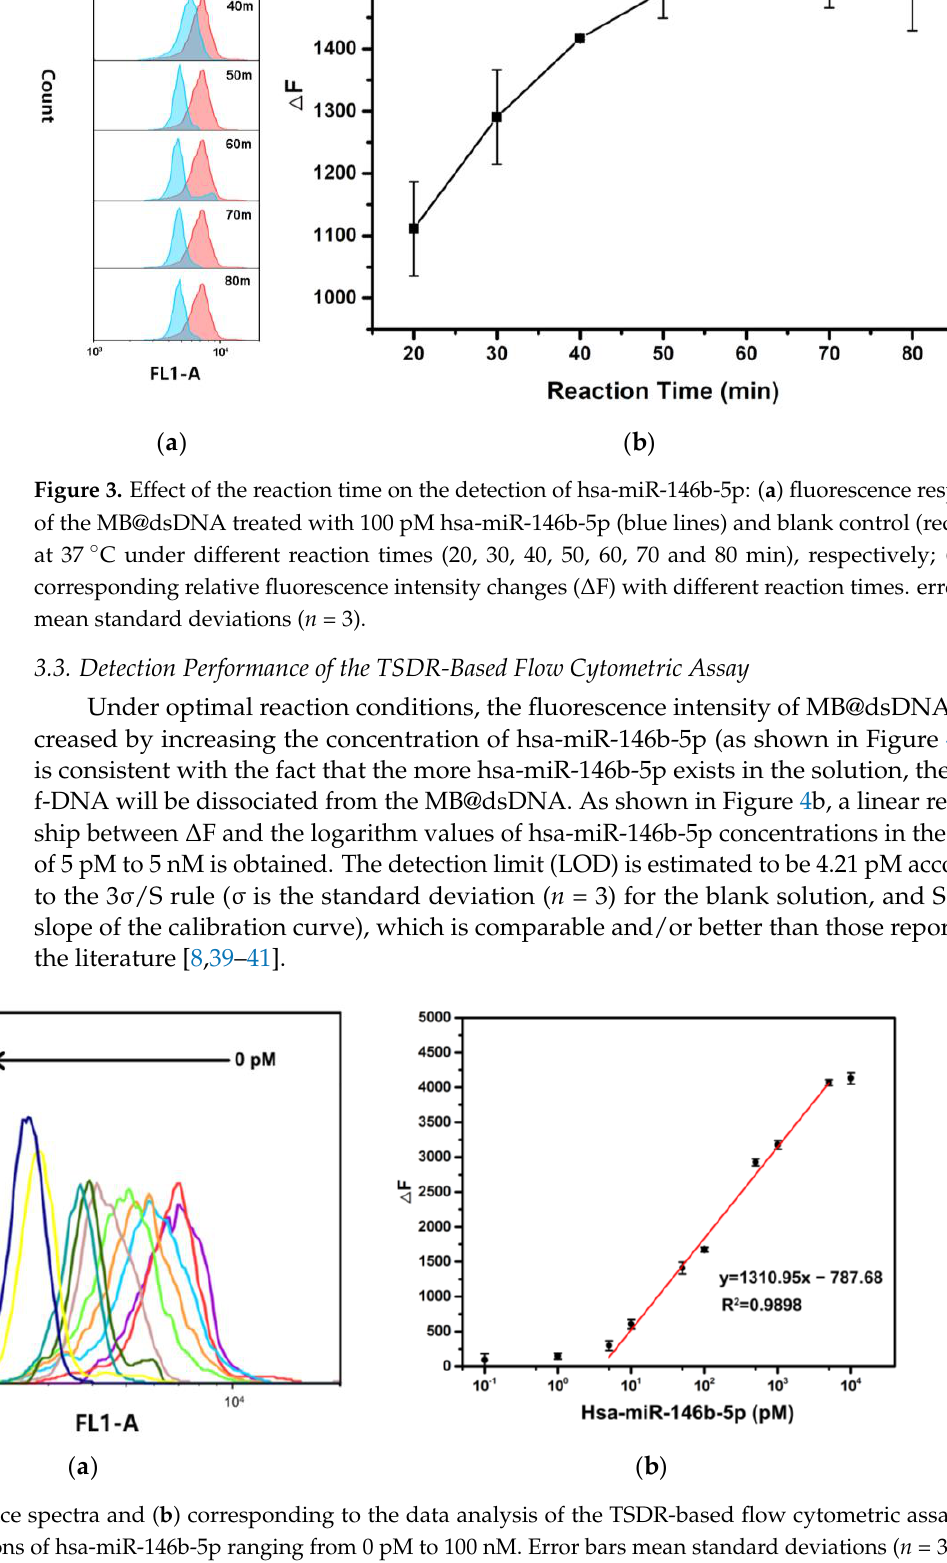
Figure 2. Effect of reaction temperature on the detection of hsa-miR-146b-5p: ( a ) fluorescence re- sponses of the MB@dsDNA treated with 100 pM hsa-miR-146b-5p (blue lines) and blank control (red lines) under different reaction temperatures (27, 32, 37, 42 and 47 °C) for 60 min, respectively; ( b ) the corresponding relative fluorescence intensity changes (ΔF) with different reaction tempera- tures. Error bars mean standard deviations ( n = 3).